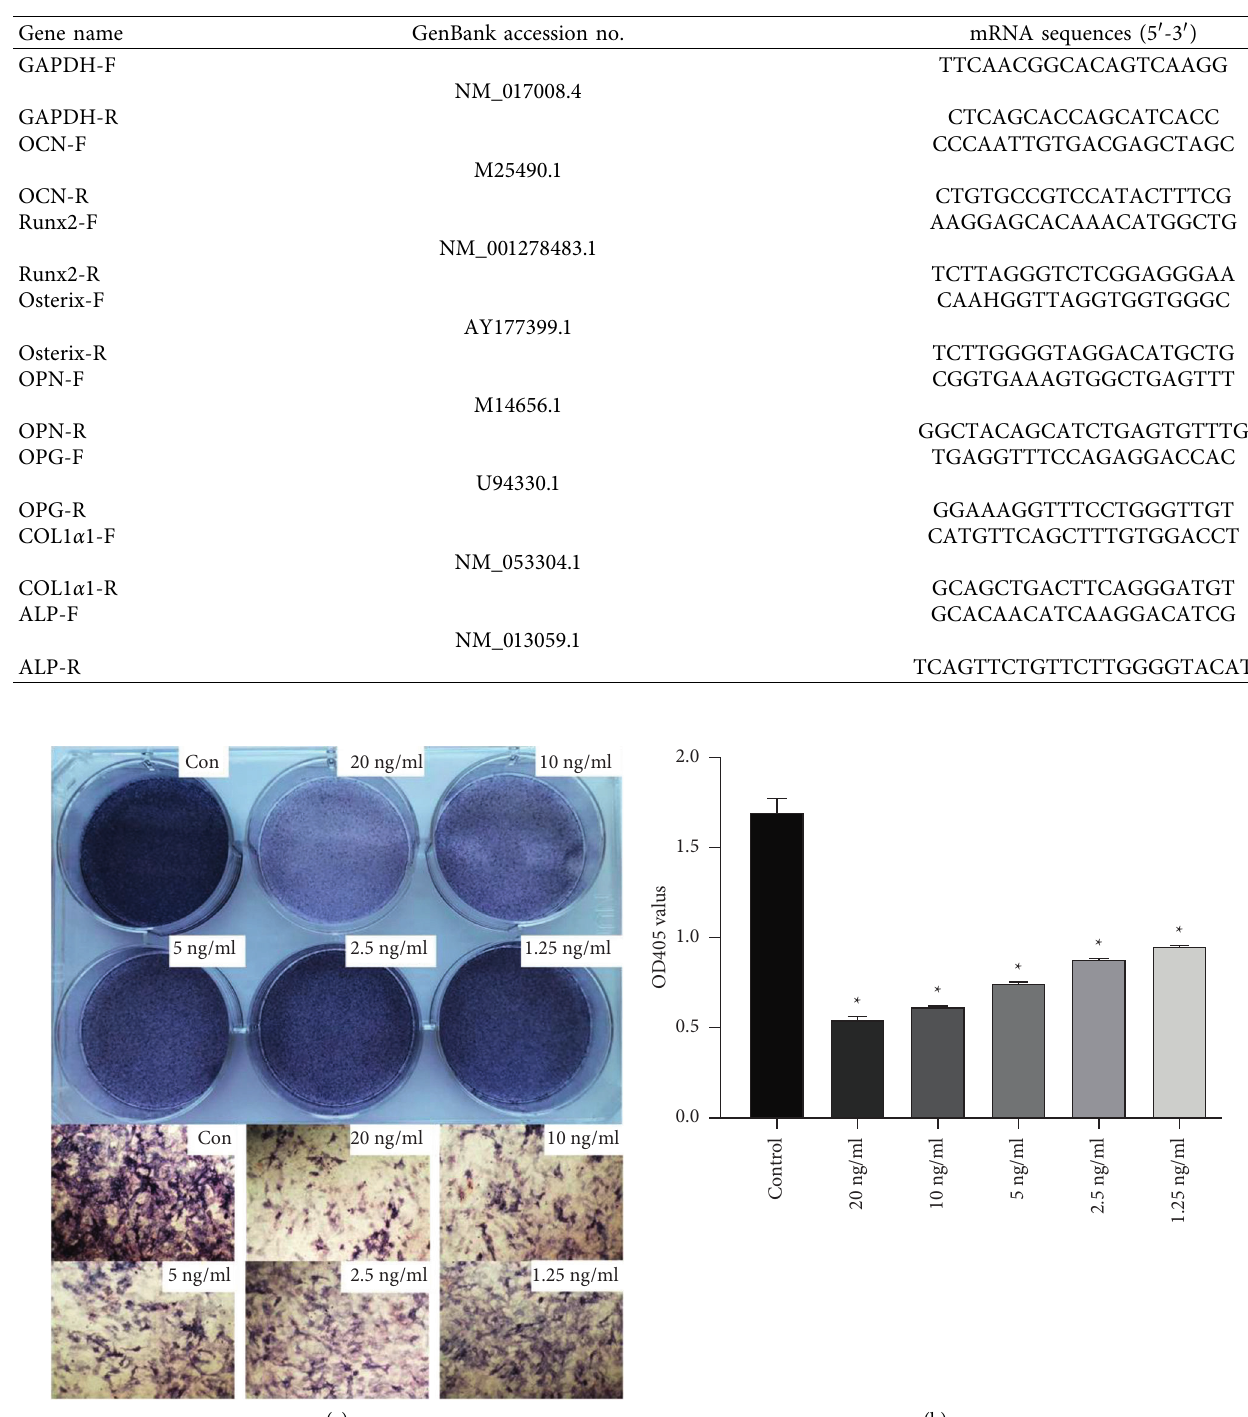
Table 1: Primers used for real-time